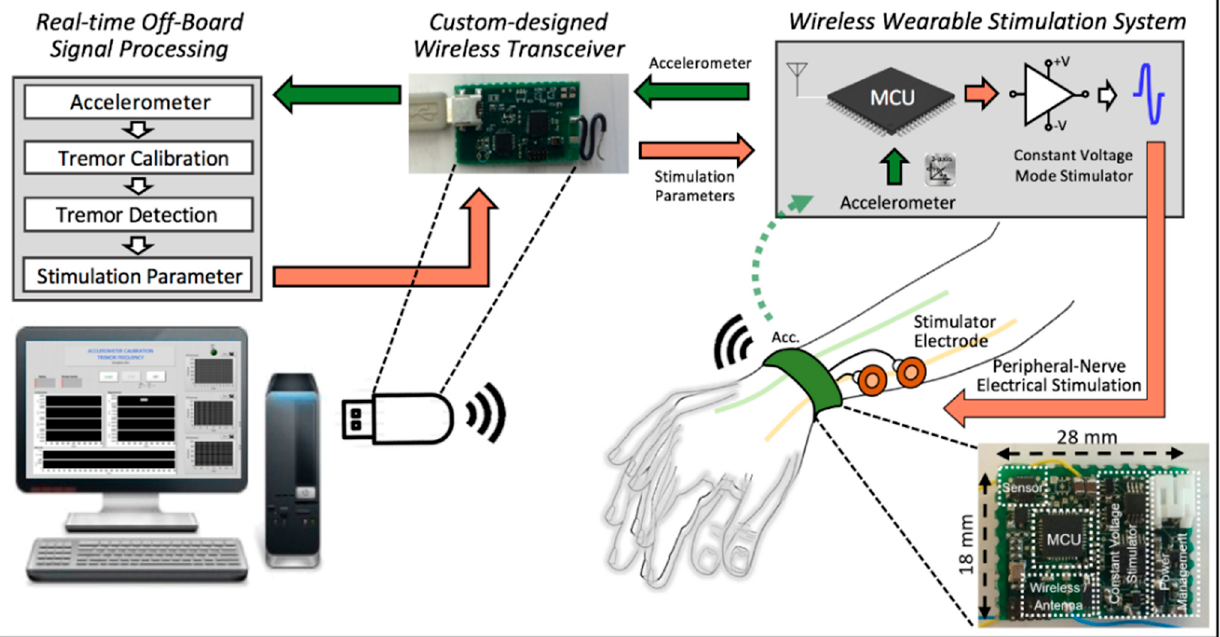
Figure 5. Overview of the real-time non-invasive tremor modulation system for essential tremor.